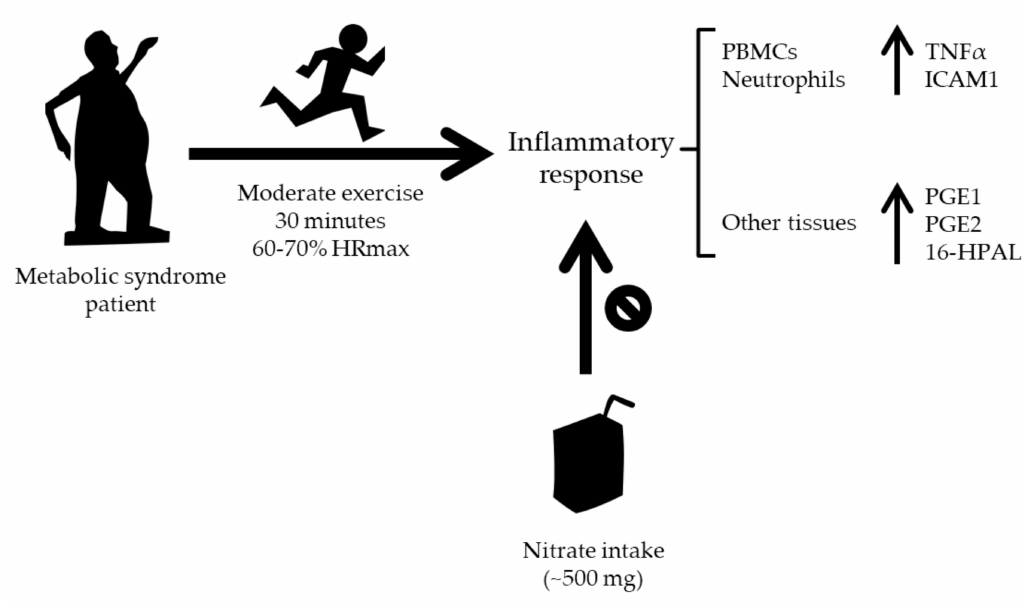
Figure 3. Graphical scheme summarizing the main findings of the article. 16-HPAL: 16-hydroxypalmitic acid; HRmax: maximal heart rate; ICAM1: intercellular adhesion molecule 1; PBMCs: peripheral